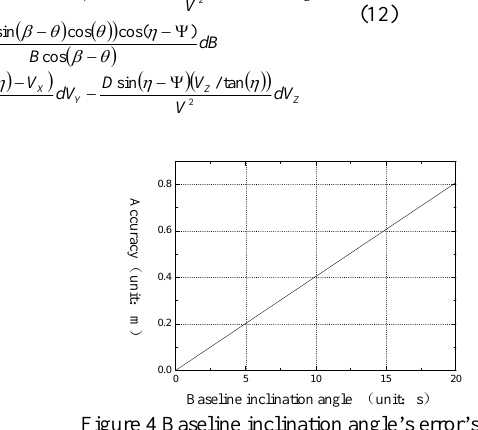
Figure 4 Baseline inclination angle’s error’s influence to altitude accuracy